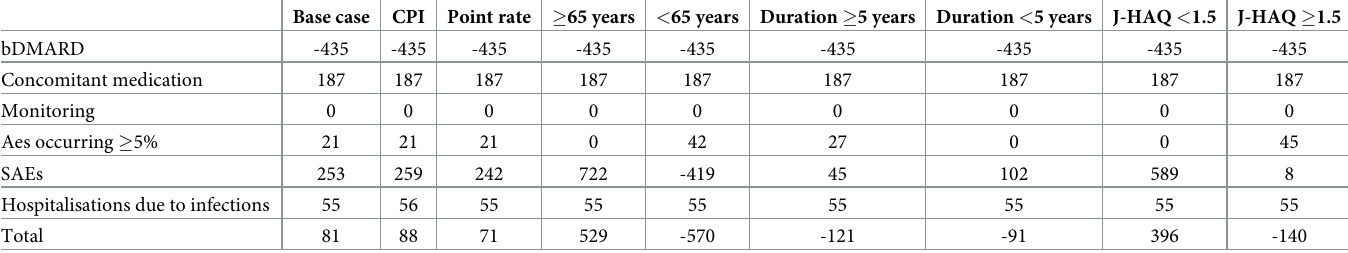
Table 10. Cost results breakdown of the model in a hypothetical cohort of 1,000 patients–per member per month (Incremental costs [ABA-1L vs.